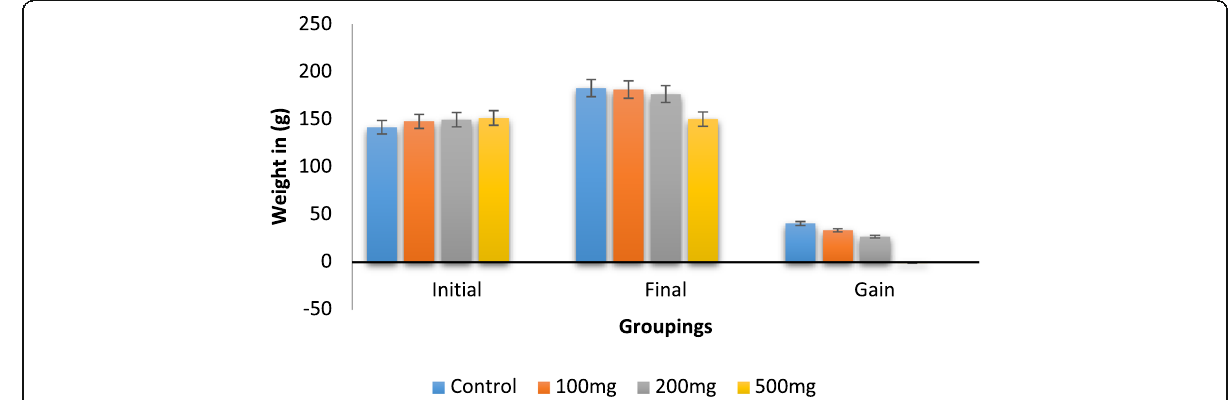
Fig. 2 Effect of Dennetia tripetalla Extract on Animal